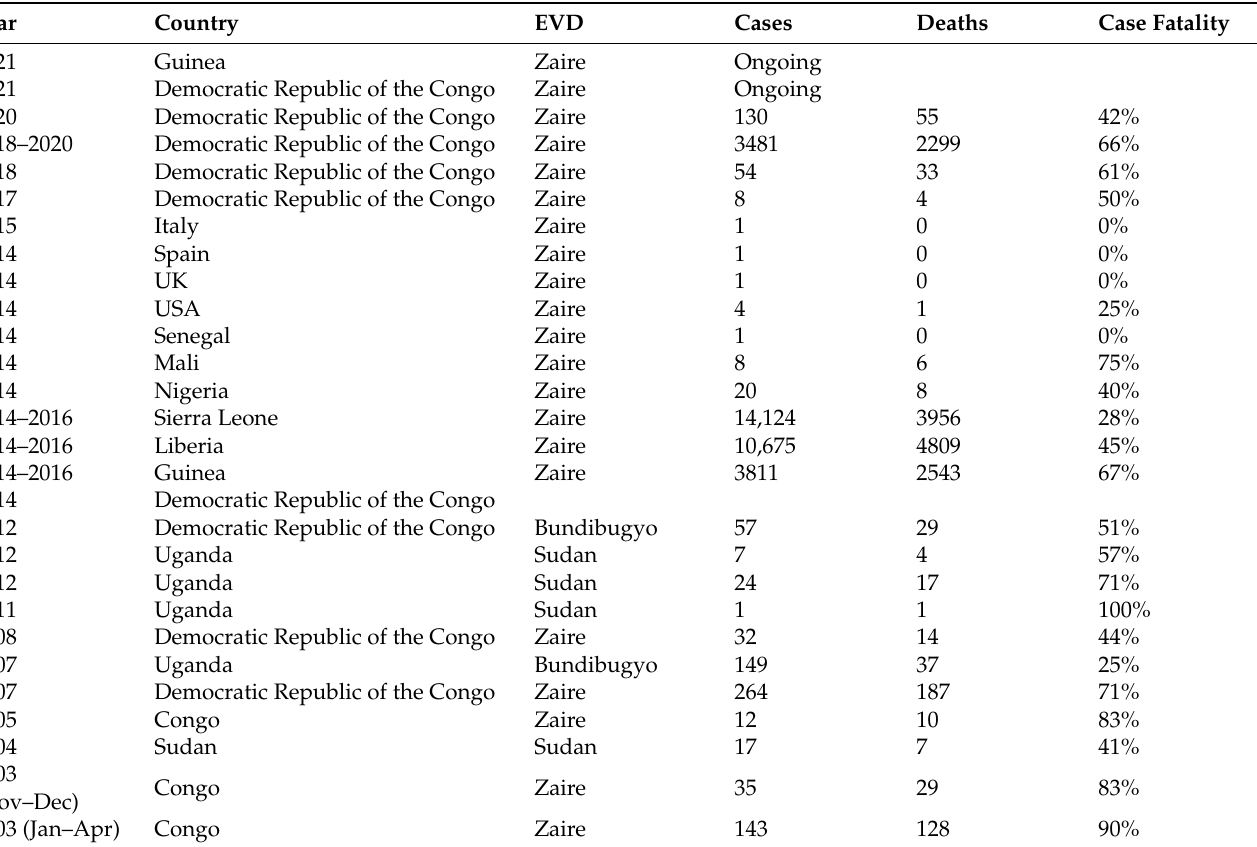
Table 1. Epidemiological outbreaks of EVD since 1976 (https://www.who.int/news-room/fact- sheets/detail/ebola-virus-disease, accessed on 8 January